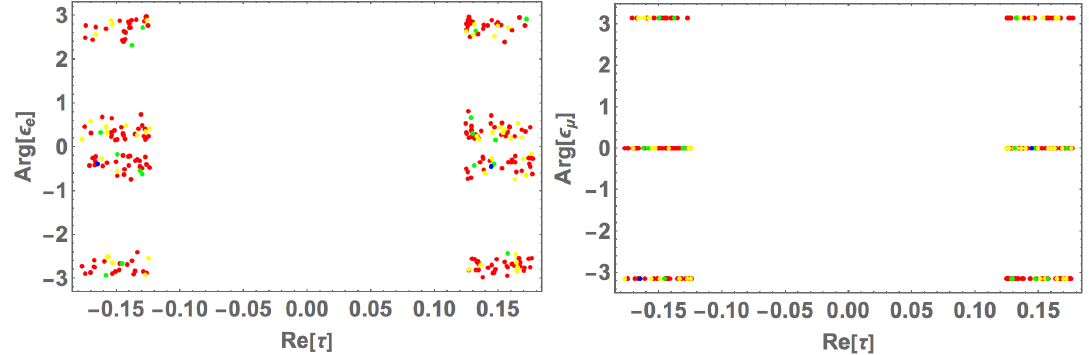
] in terms of Re[ τ ] , where the color e ( µ )